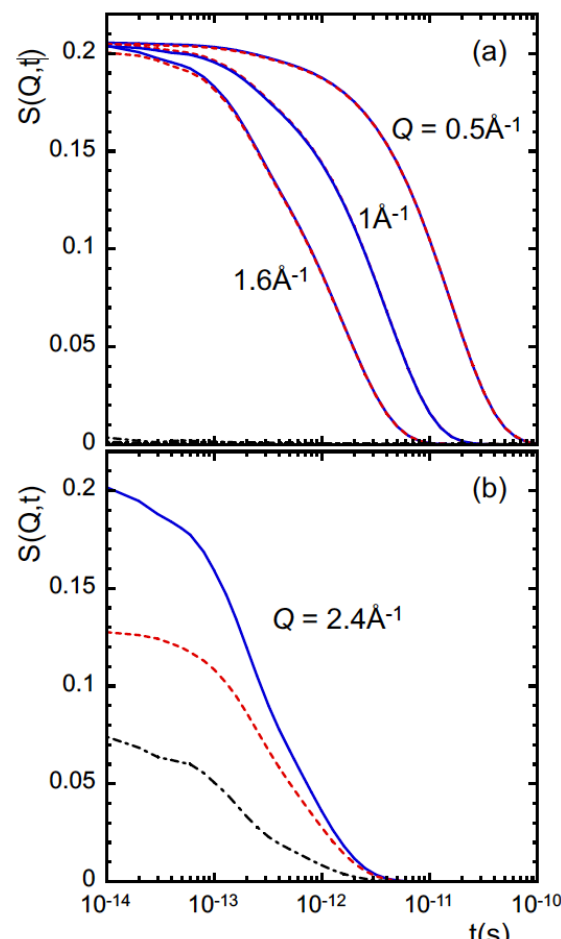
Fig. 8. Coherent dynamic structure factor S ( Q , t ) corresponding to H 0 O (black dashed-dotted line), its self part 𝑆 rstu (𝑄,𝑡) (blue continuous line), and the distinct part with opposite sign - 𝑆 v‘rh (𝑄,𝑡) (red dashed line) for Q -values: 0.5 Å 34 ; 1 Å 34 ; and 1.6 Å 34 in (a) and for 2.4 Å 34 in (b). Note that in the case of 0.5 Å 34 ; 1 Å 34 and 1.6 Å 34 , 𝑆 rstu (𝑄,𝑡) and - 𝑆 v‘rh (𝑄,𝑡) basically coincide, and the amplitude of S ( Q , t ) is almost zero in the scale of the